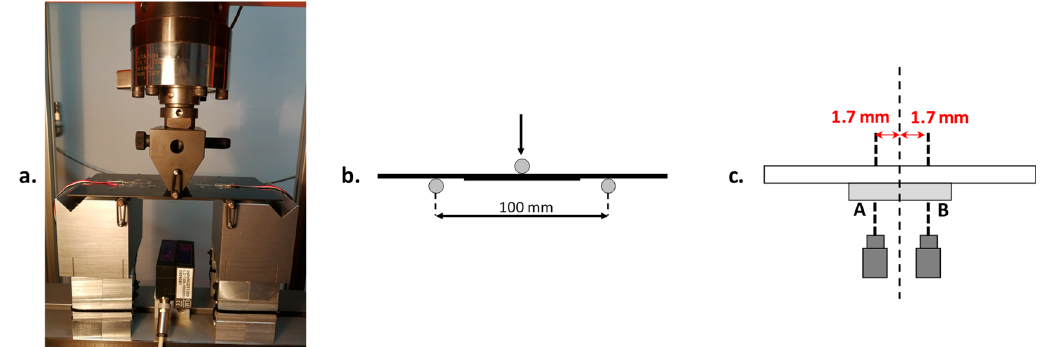
Figure 5. ( a ) Experimental set-up; ( b ) Test scheme; ( c ) Laser displacement sensors position.